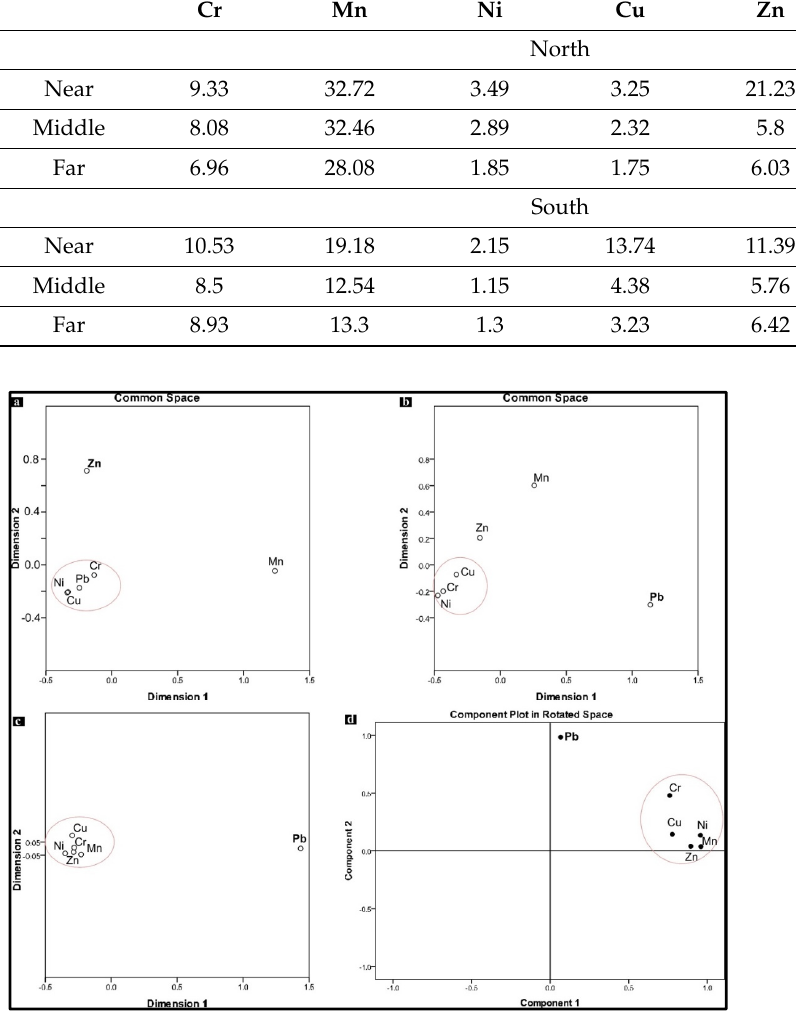
Figure 4. Multidimensional scaling of heavy metals in Jeddah coastline sediments, ( a ) MDS of metals concentration of the North location, ( b ) MDS of metals concentrations of the Middle location, ( c ) MDS of metals concentrations of the South location, and ( d ) PCA of heavy metals concentrations over the entire study region. Ellipses are drawn to demonstrated clusters of elements.